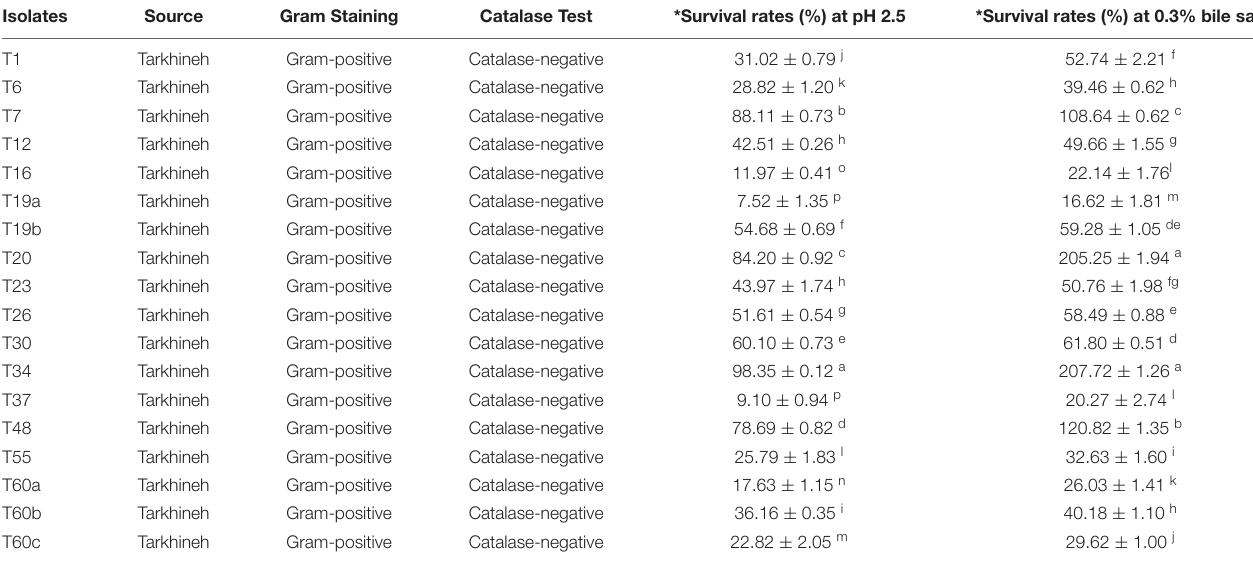
TABLE 1 | Source, gram staining, catalase test, and survival rates (%) of isolated presumptive LAB after 3 h incubation at pH 2.5 and 4 h incubation at 0.3% bile salt.